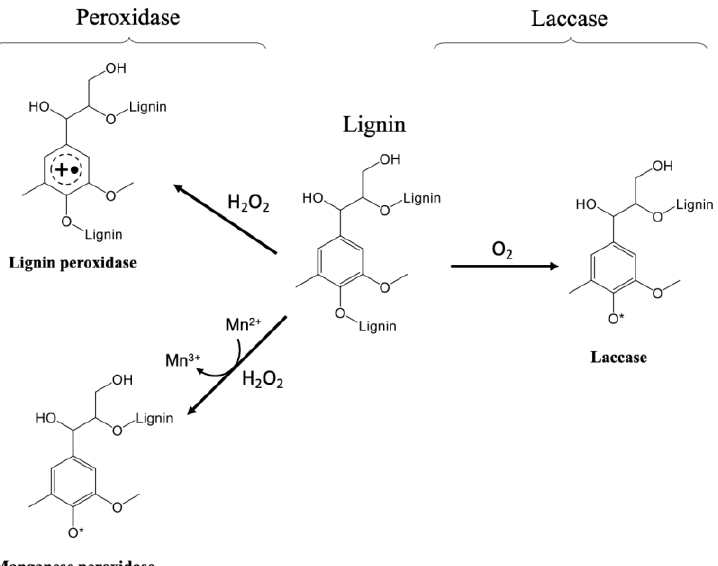
Figure 2. Classification of lignin-degrading enzymes.